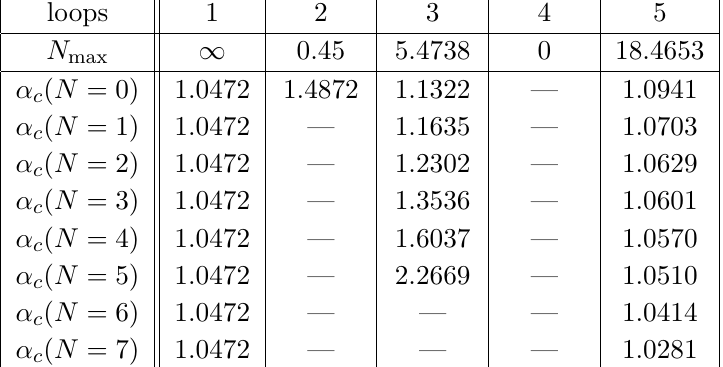
Table 2 : Critical couplings of unquenched QED symbol “—” indicates that no physical solution is